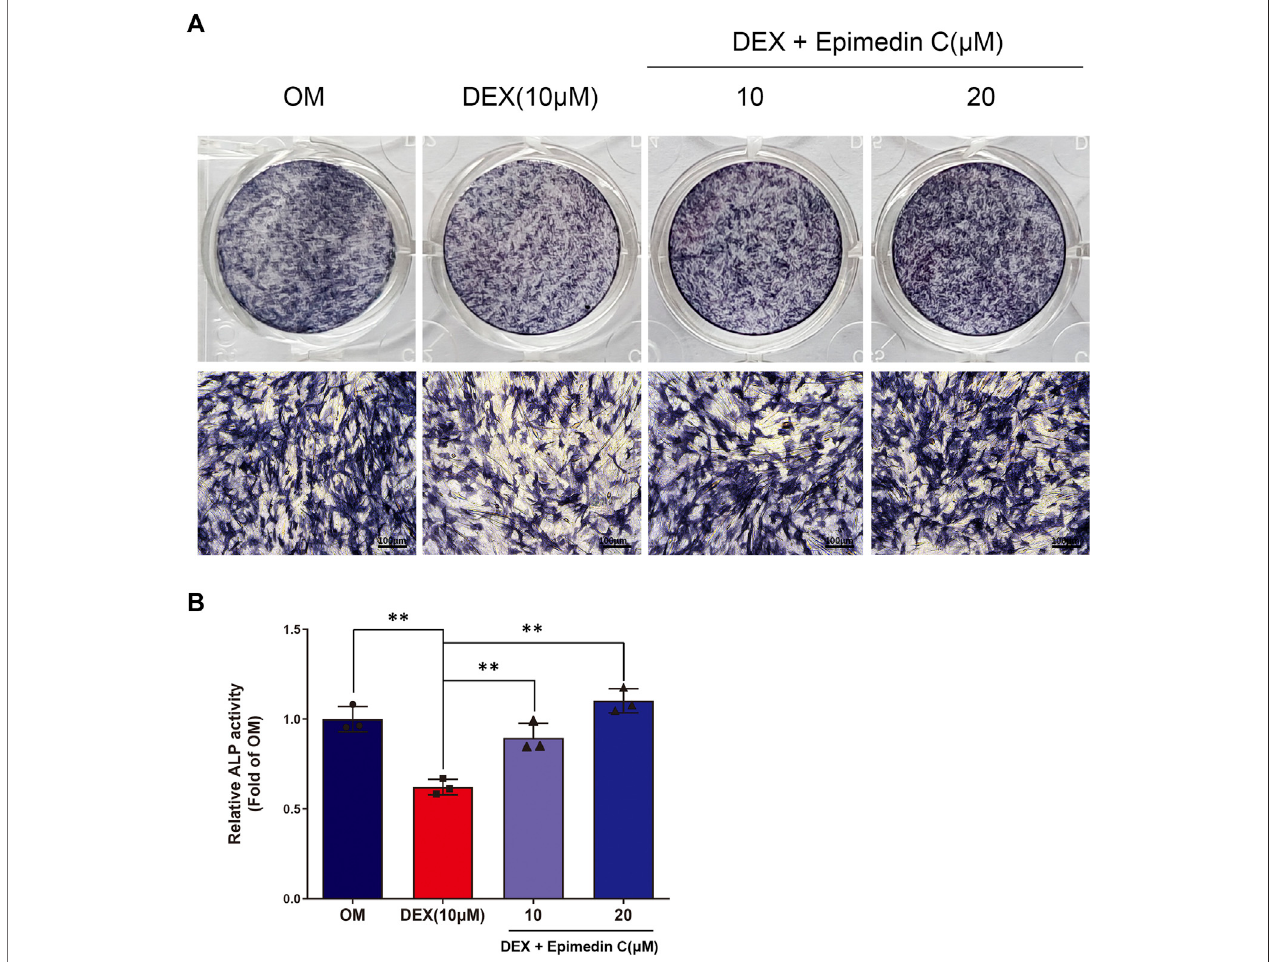
FIGURE 2 | Epimedin C ’ s impact on the action of ALP in MC3T3-E1 cells subjected to DEX treatment. (A) Following MC3T3-E1 cells treatment for 5 days using epimedinCandDEX,cellswereALPstainedwithBCIP/NBTkit. (B) MC3T3-E1cellswereconcurrentlyfor5daystreatedusingepimedinC(10,20 μ M)andDEX(10 μ M) in OM, and the activity of ALP was determined. **p < 0.01